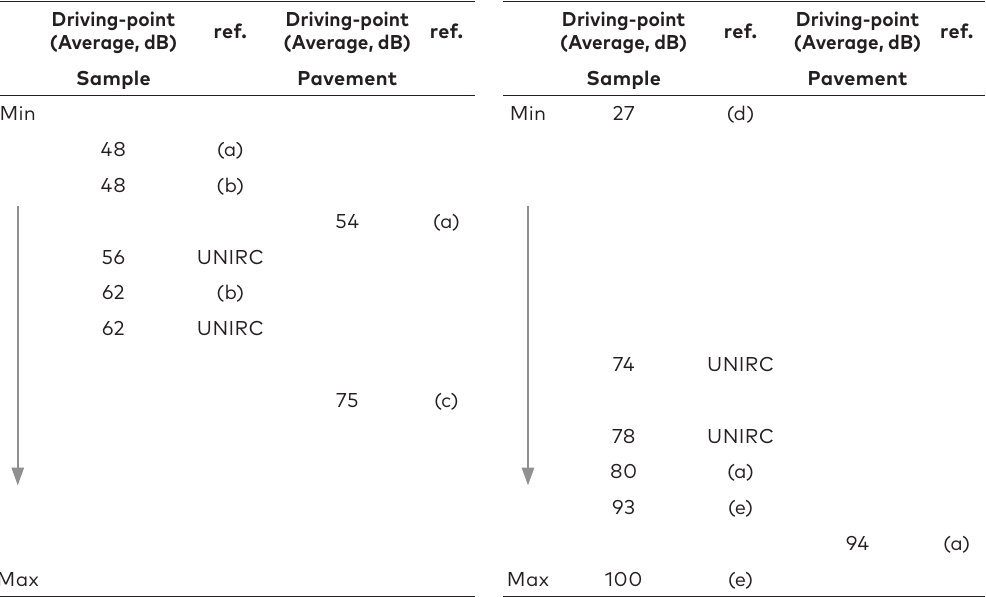
Table 12. Driving-point impedance and transfer impedance values Driving-point (Average,